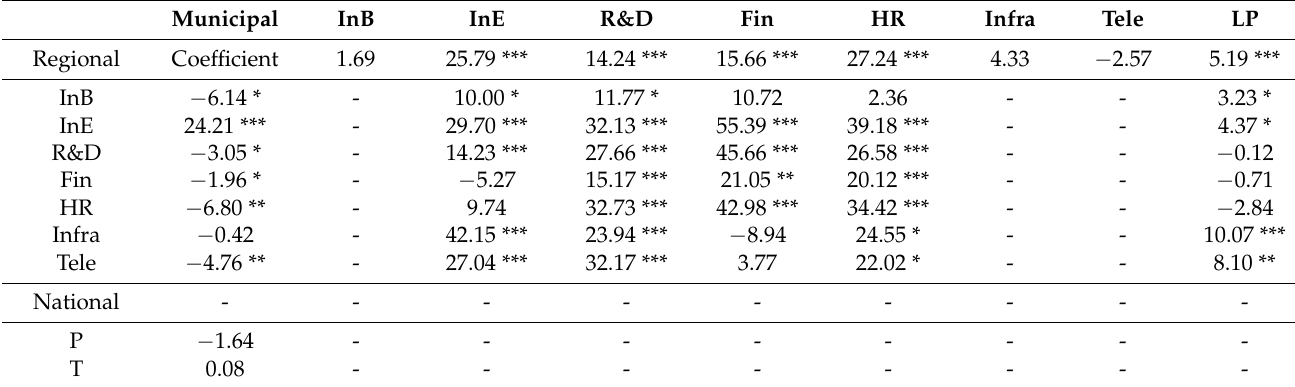
Table 4. The multilevel analysis results of innovation